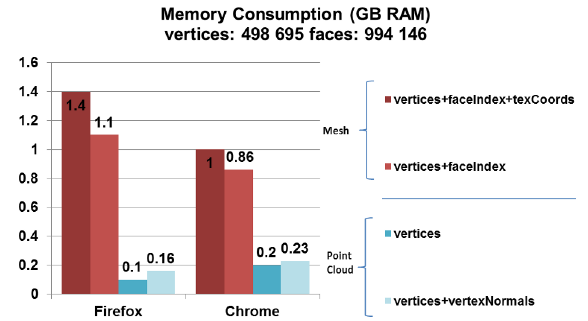
Figure 1. Memory consumption visualizing large 3D models using